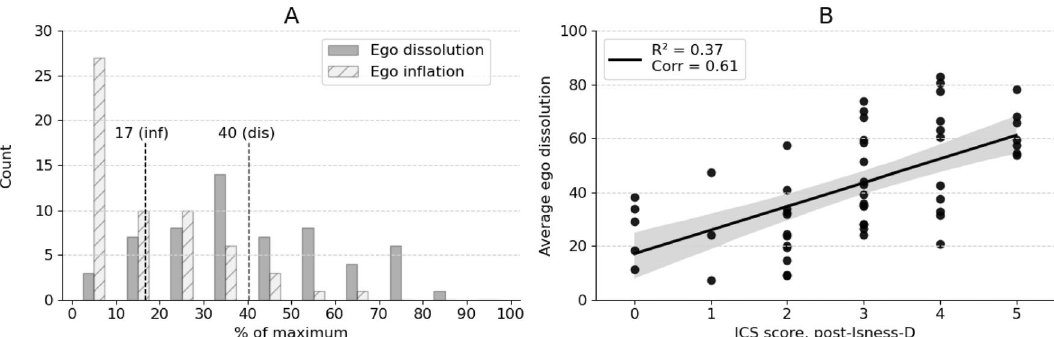
Figure 6. ( A ) distributions of the average scores for the ego inflation and ego dissolution items of the EDI across the Isness participants. The respective averages are indicated by the dashed lines. ( B ) scatter plot of the average ego dissolution against the post-Isness-D ICS scores for each participant, with a line of best fit calculated using a linear least-squares regression. The legend gives the Pearson correlation coefficient (‘corr’) and the R 2 value. The corresponding p-value is 1.13 × 10 –6